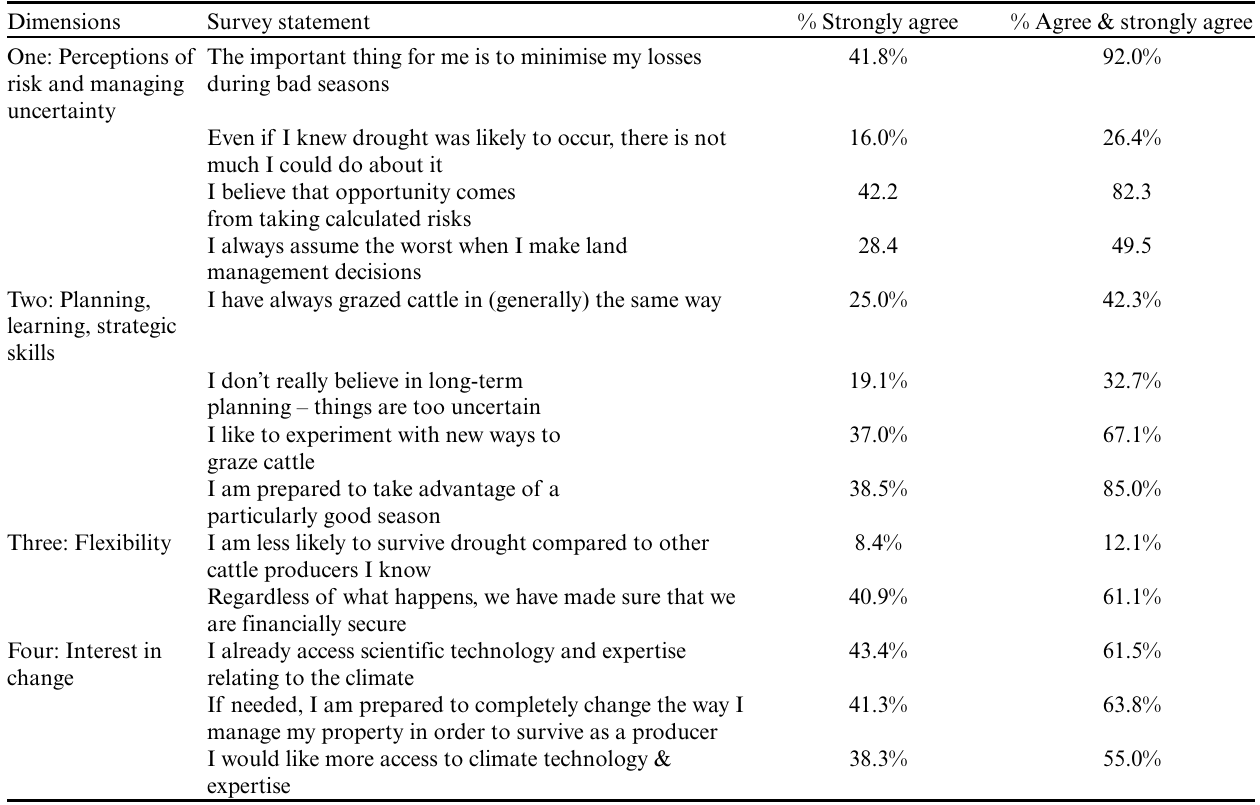
Table 1 . Level of adaptive capacity within the cattle industry of northern